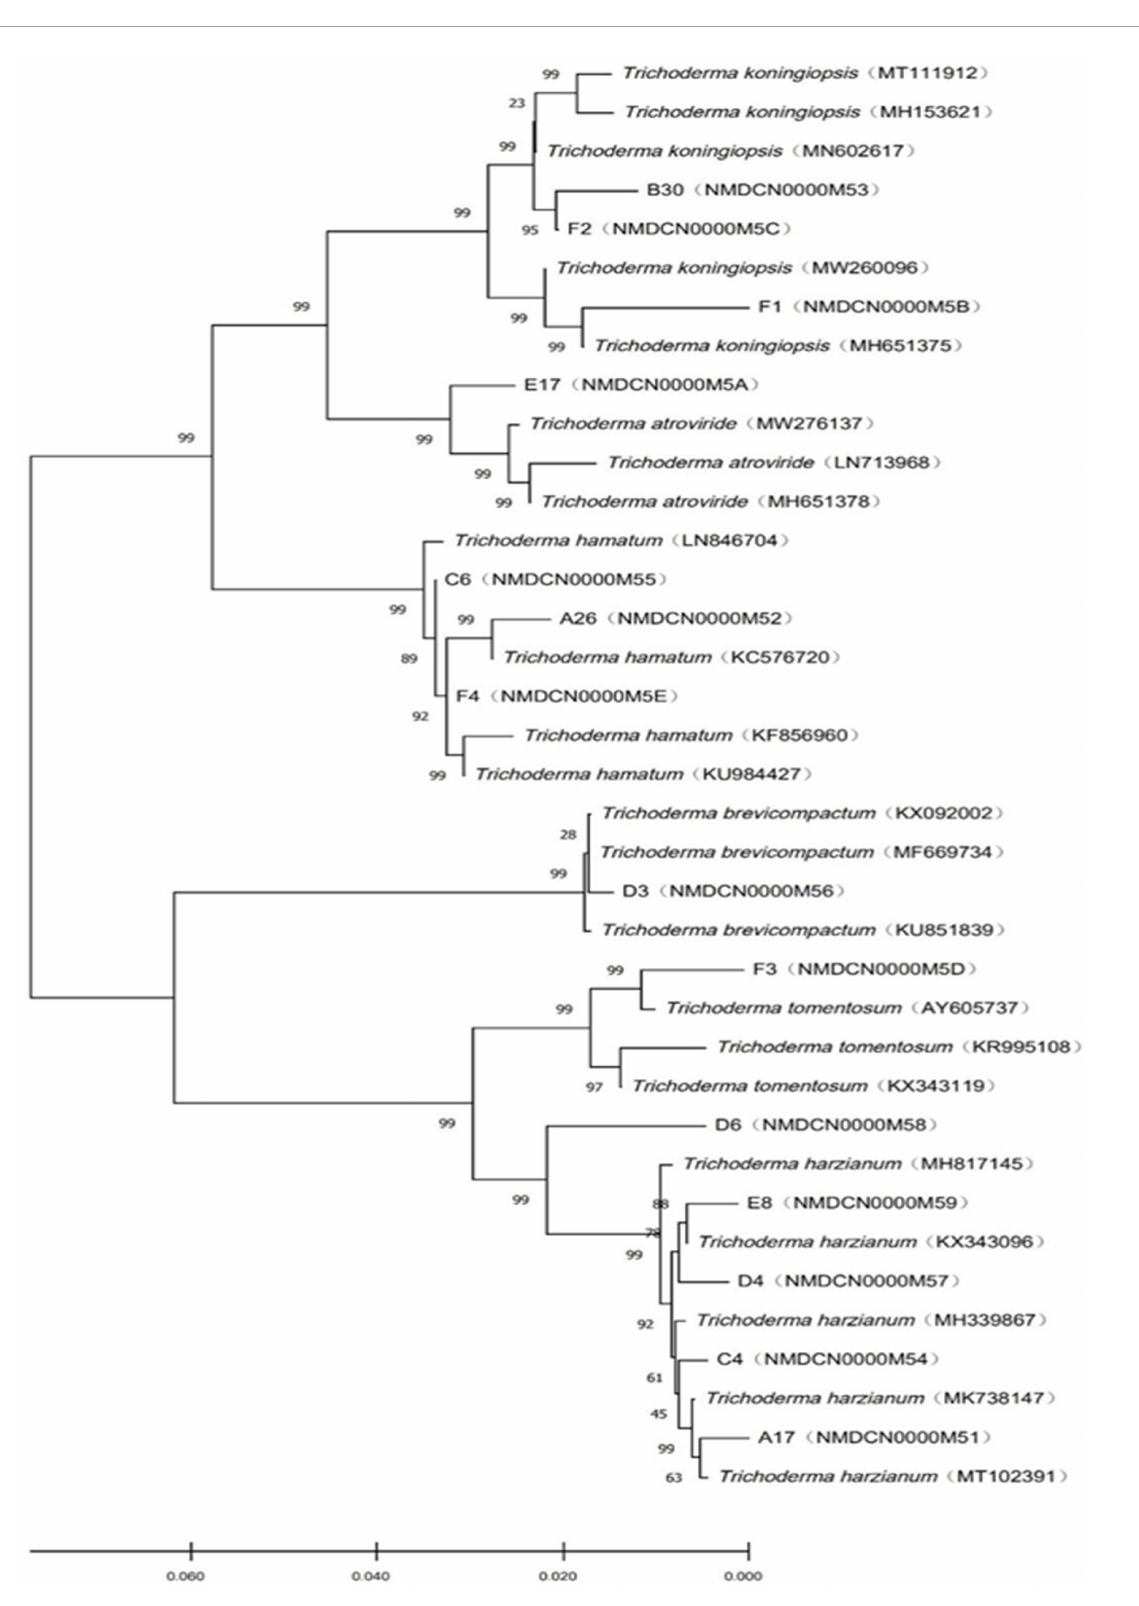
FIGURE2 Phylogenetic tree of Trichoderma constructed based on the ITS-RPB2 double sequence alignment.